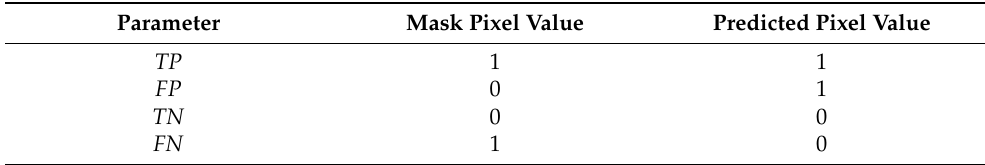
Table 2. Definition of parameters TP, FP, TN, FN between mask pixel values and predicted pixel